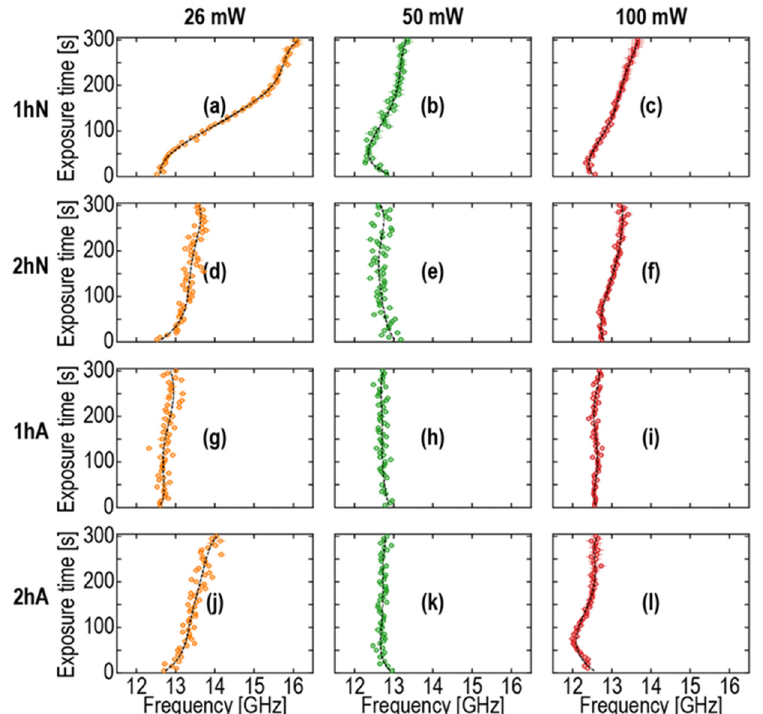
Figure 6. Changes in Brillouin frequency with the duration of the TDBS measurements at different powers of pump laser pulses (marked at the top of the figure) with a 3 mW probe power in the 1 hN (first row, ( a – c )), 2 hN (second row, ( d – f )), 1 hA (third row, ( g – i )), and 2 hA (last row, ( j – l )) samples.